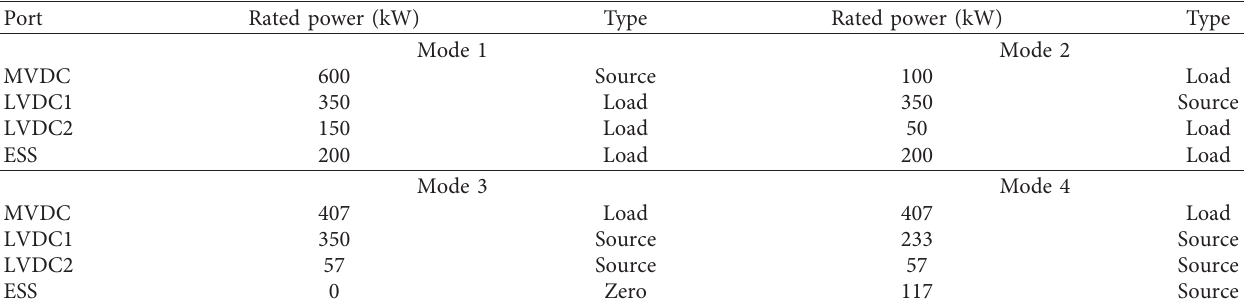
Table 3: Working parameters of four